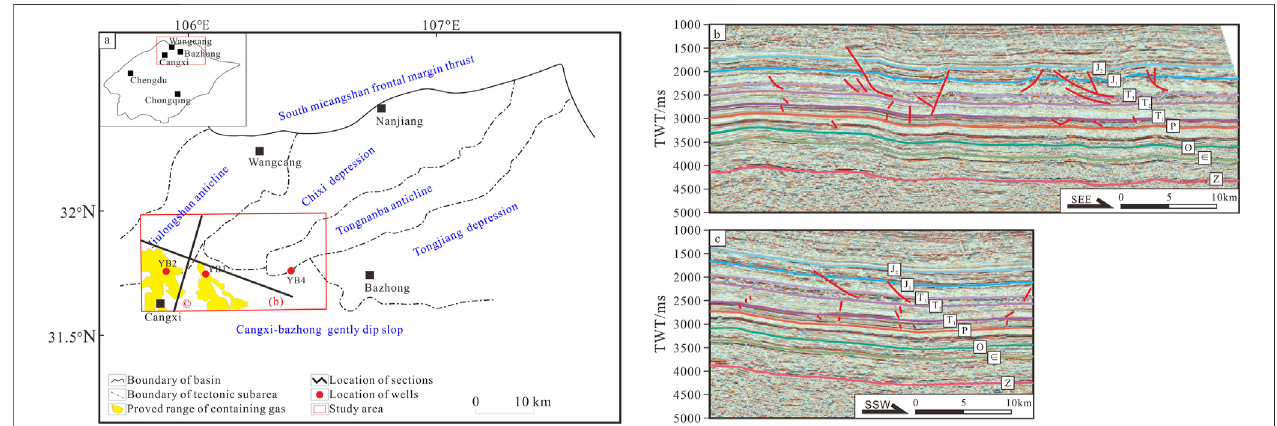
FIGURE 1 | Tectonic location and 2D seismic pro fi les of the Yuanba Gas Field. (A) Location of the study area and seismic pro fi les (modi fi ed after Guo et al., 2018); (B) NWW-SEE seismic pro fi le; (C) NNE-SSW seismic pro fi le.